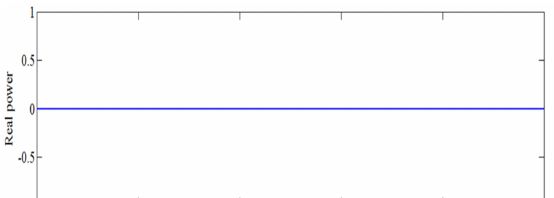
Figure 14. Block diagram of Case I.